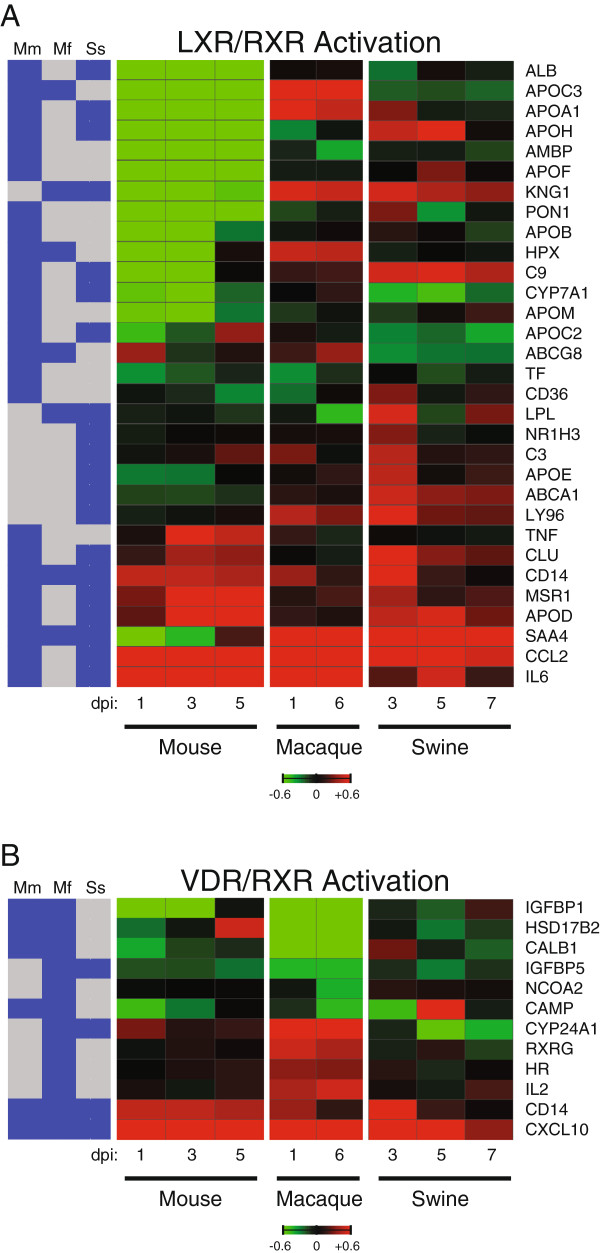
CA04 virus induces different RXR signaling-mediated responses in each species.A) Average log10(ratio) expression of 31 LXR/RXR DE genes induced by CA04 virus. In mice and swine, infected lung gene expression is referenced to specie-matched mock at each time point. In macaques, infected lung gene expression is relative to an uninfected lung reference pool at each time point. Red indicates expression was increased relative to the control reference and green indicates that expression was decreased relative to the control reference. Saturation is 4-fold. B) Average log10(ratio) expression of 12 VDR/RXR DE genes induced by CA04 virus. In mice and swine, infected lung gene expression is referenced to specie-matched mock at each time point. In macaques, infected lung gene expression is relative to an uninfected lung reference pool at each time point. Red indicates expression was increased relative to the control reference and green indicates that expression was decreased relative to the control reference. Saturation is 4-fold. The association of each DE gene within a given species is shown on the left; blue denotes differential expression and gray denotes no differential expression. The following abbreviations are used: Mm, Mus musculus (mouse); Mf, Macaca fascicularis (macaque); and Ss, Sus scrofa (swine).